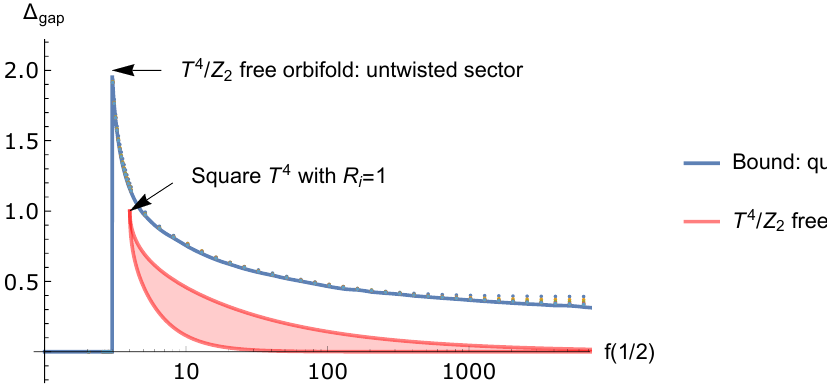
Figure 4 . The dots indicate the upper bound b (cid:1) gap on the gap versus f (1 = 2), the four-point function evaluated at the crossing symmetric point, at derivative orders ranging from 8 to 20. The solid line plots the extrapolation to in(cid:12)nite order using a quadratic (cid:12)t. The minimal f (1 = 2) and maximal gap are simultaneously saturated by an untwisted sector correlator at the free orbifold point. The shaded region represents the gap in the OPE of twist (cid:12)elds at a (cid:12)xed point of T 4 = Z 2 with a rectangular T 4 , where the minimal f (1 = 2) and maximal gap are achieved by a square T 4 at radii R i = 1 (1 = p 2 times the self-dual